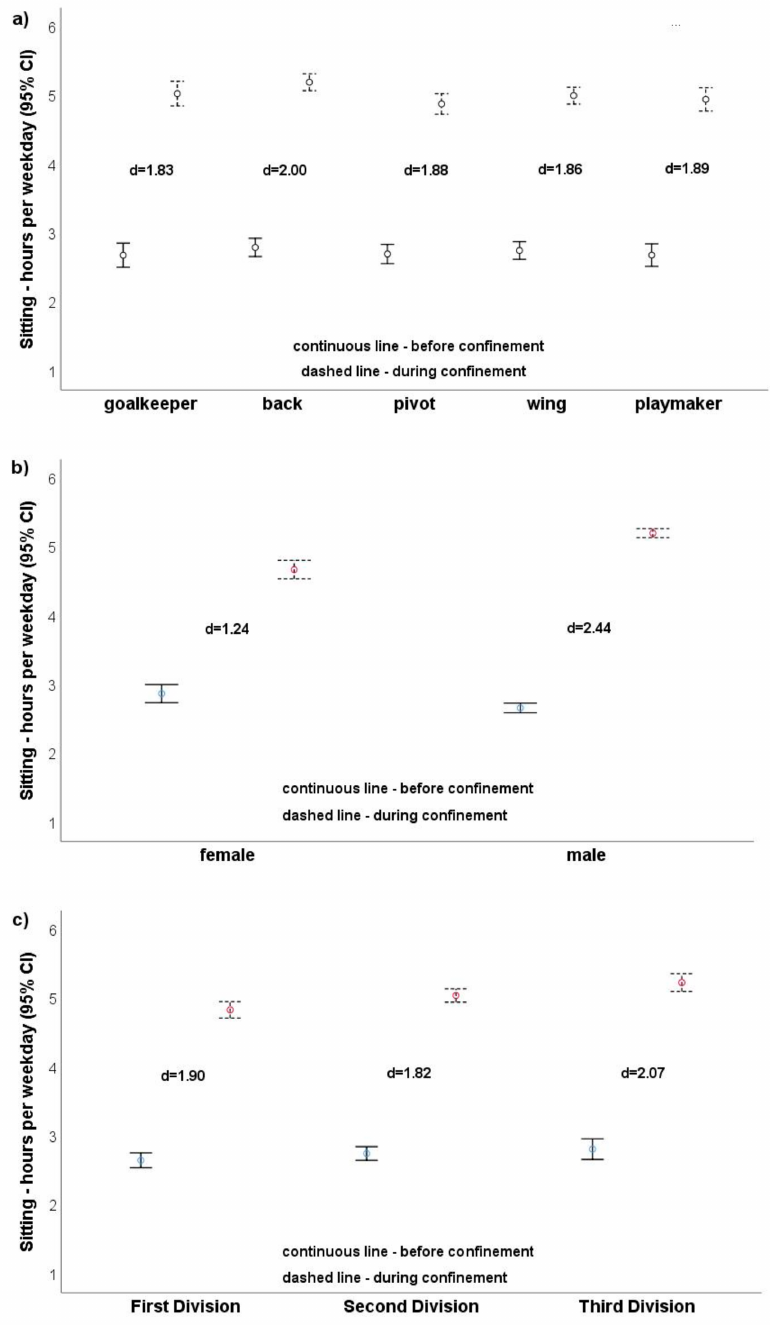
Figure 1. ( a – c ). Sitting hours per weekday depending on playing positions ( a ), gender ( b ), and level of handball league ( c